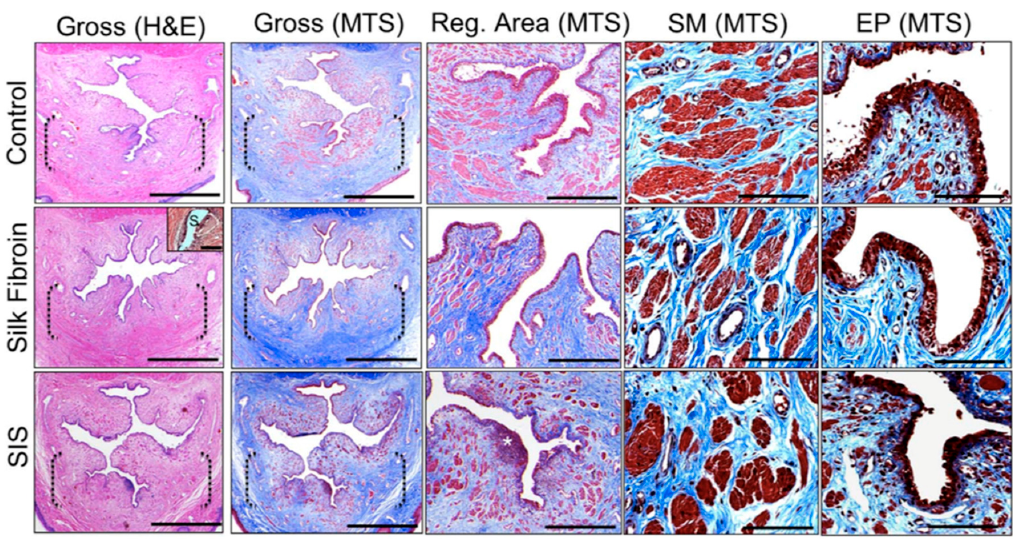
Figure 5. Histological analysis of urethral tissue regrowth 3 months following implantation of silk fibroin based scaffold (first and second columns). Scale bars = 3 mm. Inset: residual silk fibroin matrix fragment (S). Scale bars = 100 mm. Dashed brackets represent areas of scaffold implantation or control urethrotomy (third column). Global tissue regeneration bracketed in second column. Scale bars = 600 mm. (*) = aggregate of mononuclear cells indicative of chronic inflammation (fourth and fifth columns). Magnified de novo smooth muscle (SM) and epithelial (EP) tissue formation displayed in third column. (H&E) hematoxylin and eosin, (MTS) Masson trichrome stain. Scale bars = 200 mm. It shows that both silk fibroin and SIS scaffolds promoted similar extents of smooth muscle and epithelial tissue regeneration throughout the original defect sites with prominent contractile protein. (reproduced with permission from [86]). © 2014 Chung et al.